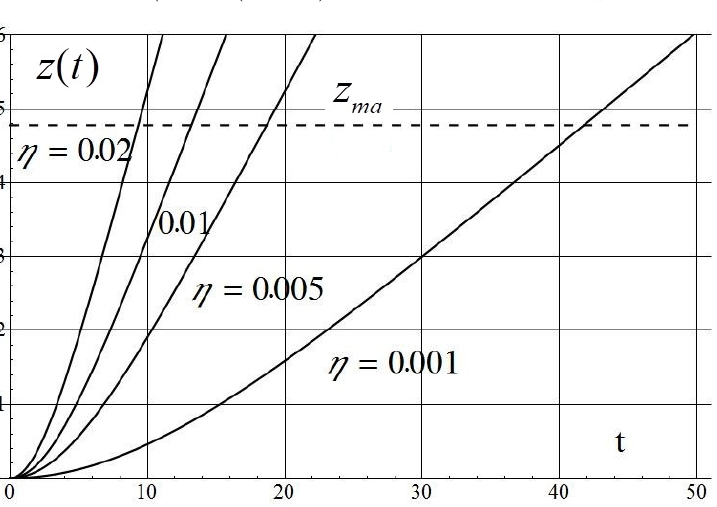
Figure 1. Submersion of the cylinder versus time in accelerated motion for an instantaneous change in buoyancy ( t 0 = 0 ) and various magnitudes of η , l c = 1 m.